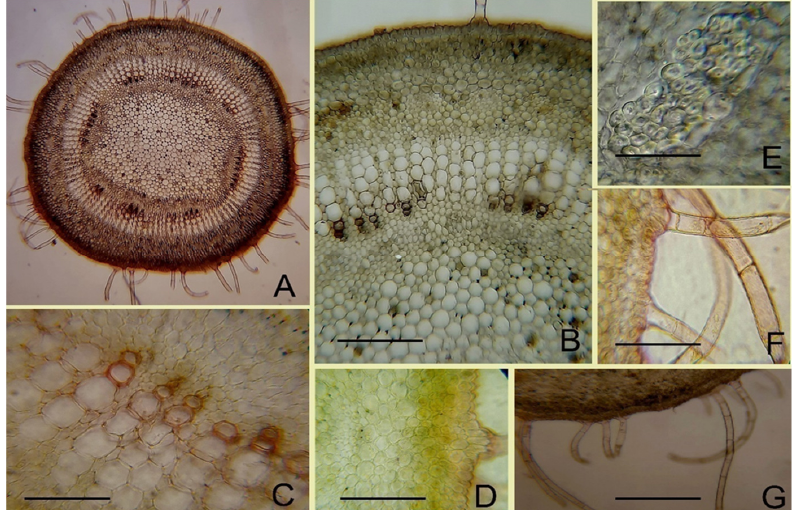
Figure 2. A. Very young stem, B. Portion showing the large conglomerate of protoxylem, C. Square metaxylem cells alternating with ray initials, D. Cortex, hypodermis and epidermis, E. Cortex with developing gelatinous fibres F. Hypodermis of chlorenchyma, G. Multicellular uniseriate trichomes. Scale bar: 400 µ (B, G), and100µ (C, D, E,